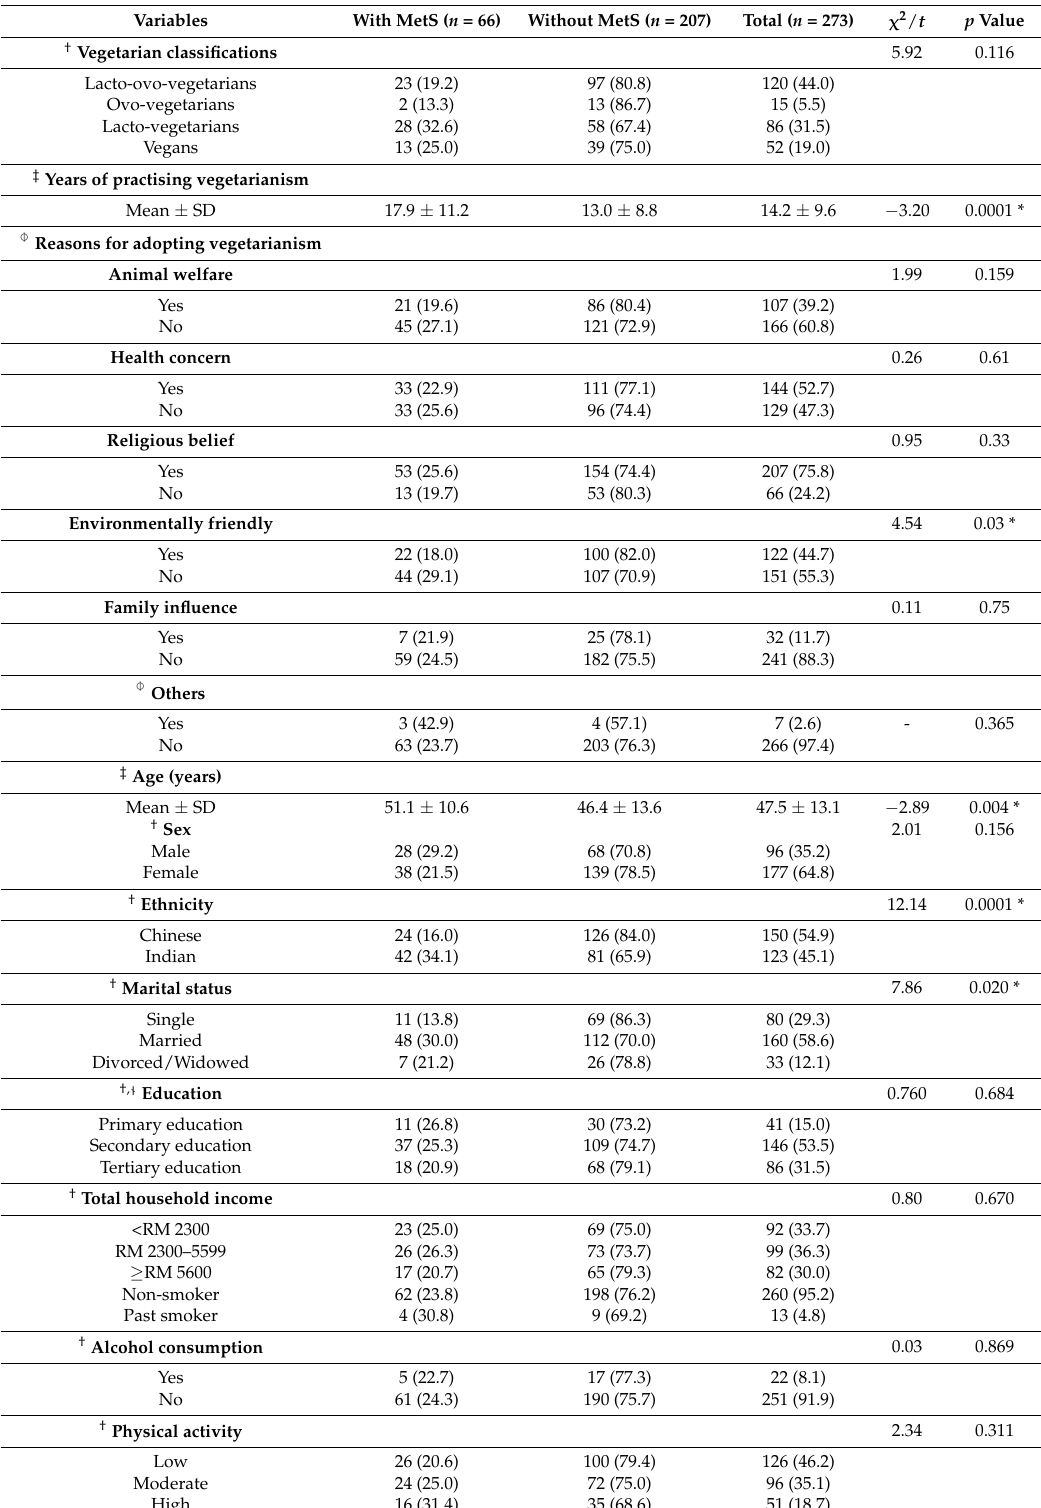
Table 3. Factors associated with